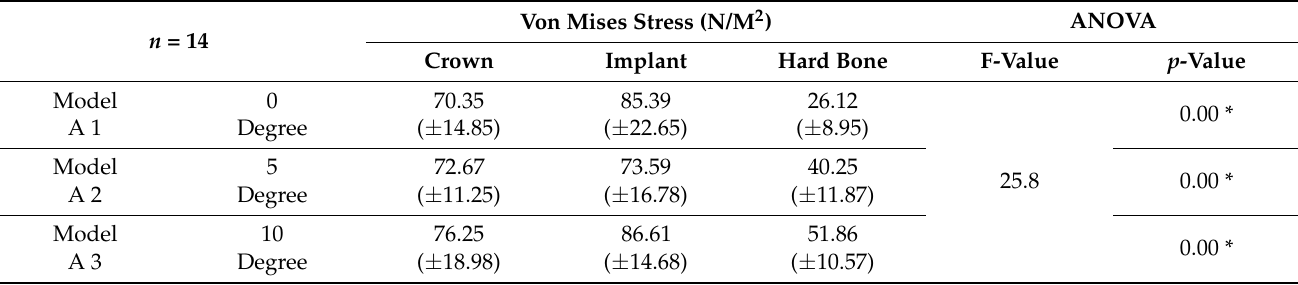
0.04 Figure 5. Direction of force in model B1.